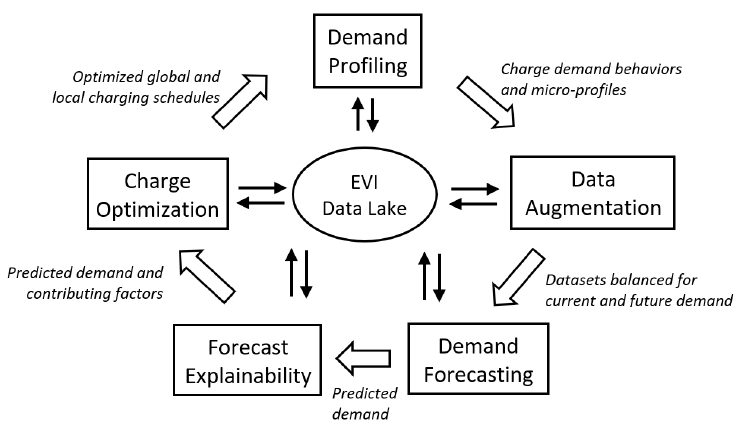
Figure 1. Hierarchical composition of EVI in a smart grid setting.